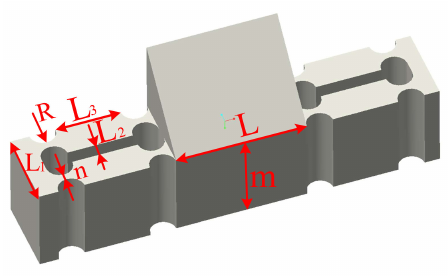
Figure 2. Drive flexure hinge model. Table 1. Specific parameters of mechanism.